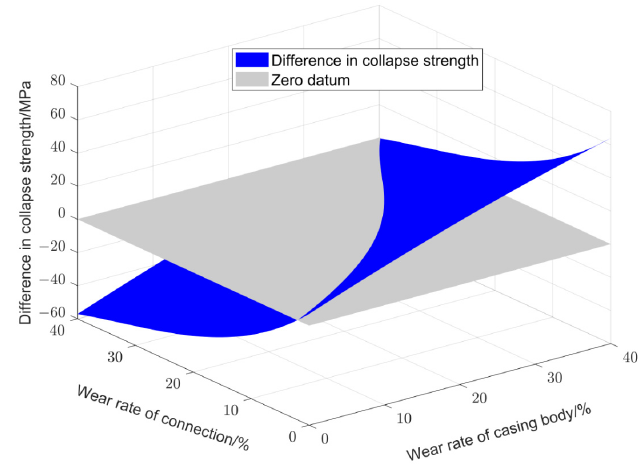
Figure 15. The difference of collapse strength between connection and body varies with wear rate.